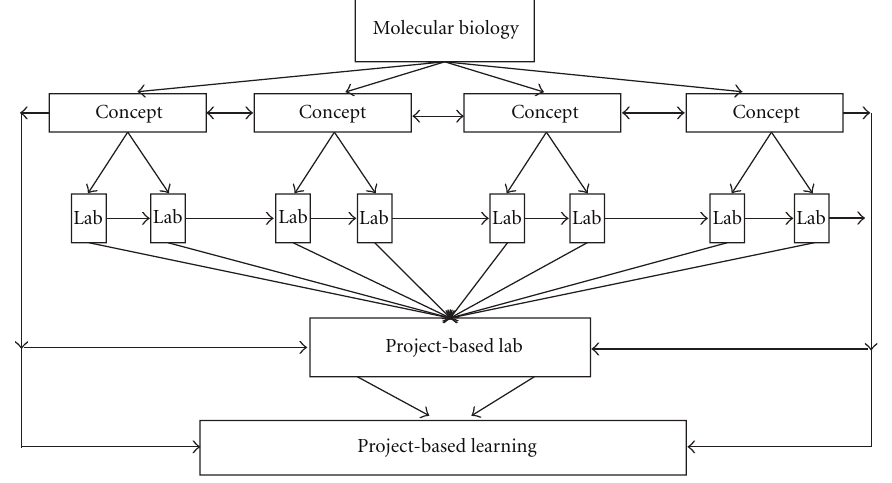
Figure 1: Concept map for project-based